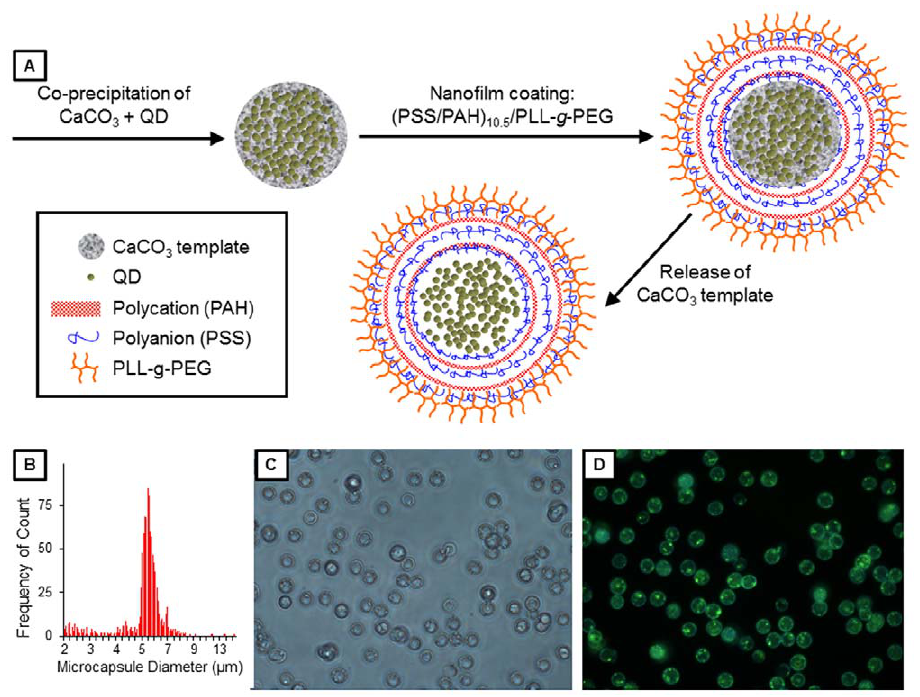
Figure 1. Quantum dot-loaded microcapsule characterization. (A) Schematic representation of the formation of QD-loaded microcapsules. (B) Histogram of the size distribution of QDMCs. (C) Brightfield and (D) fluorescence images of the QDMCs, showing that the microcapsules are monodisperse and contain QDs (ex/em 380/545).